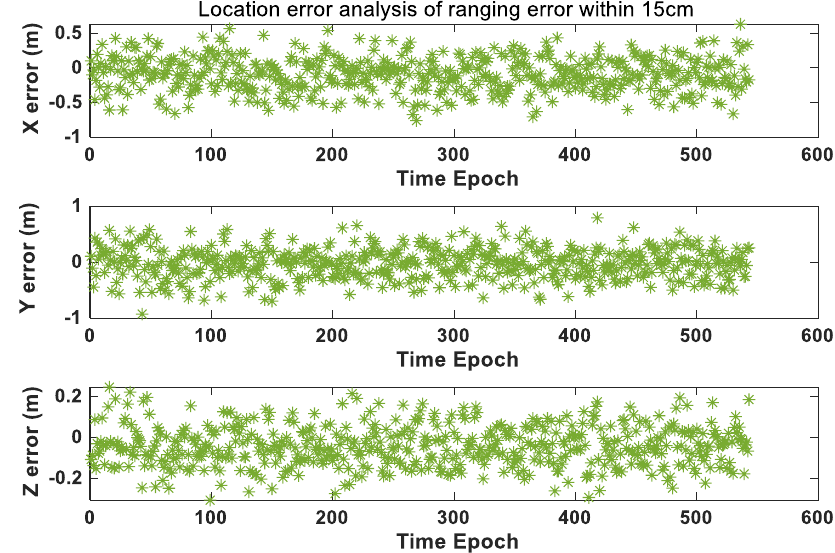
Figure 13. Positioning accuracy analysis when ranging accuracy is within 15 cm.